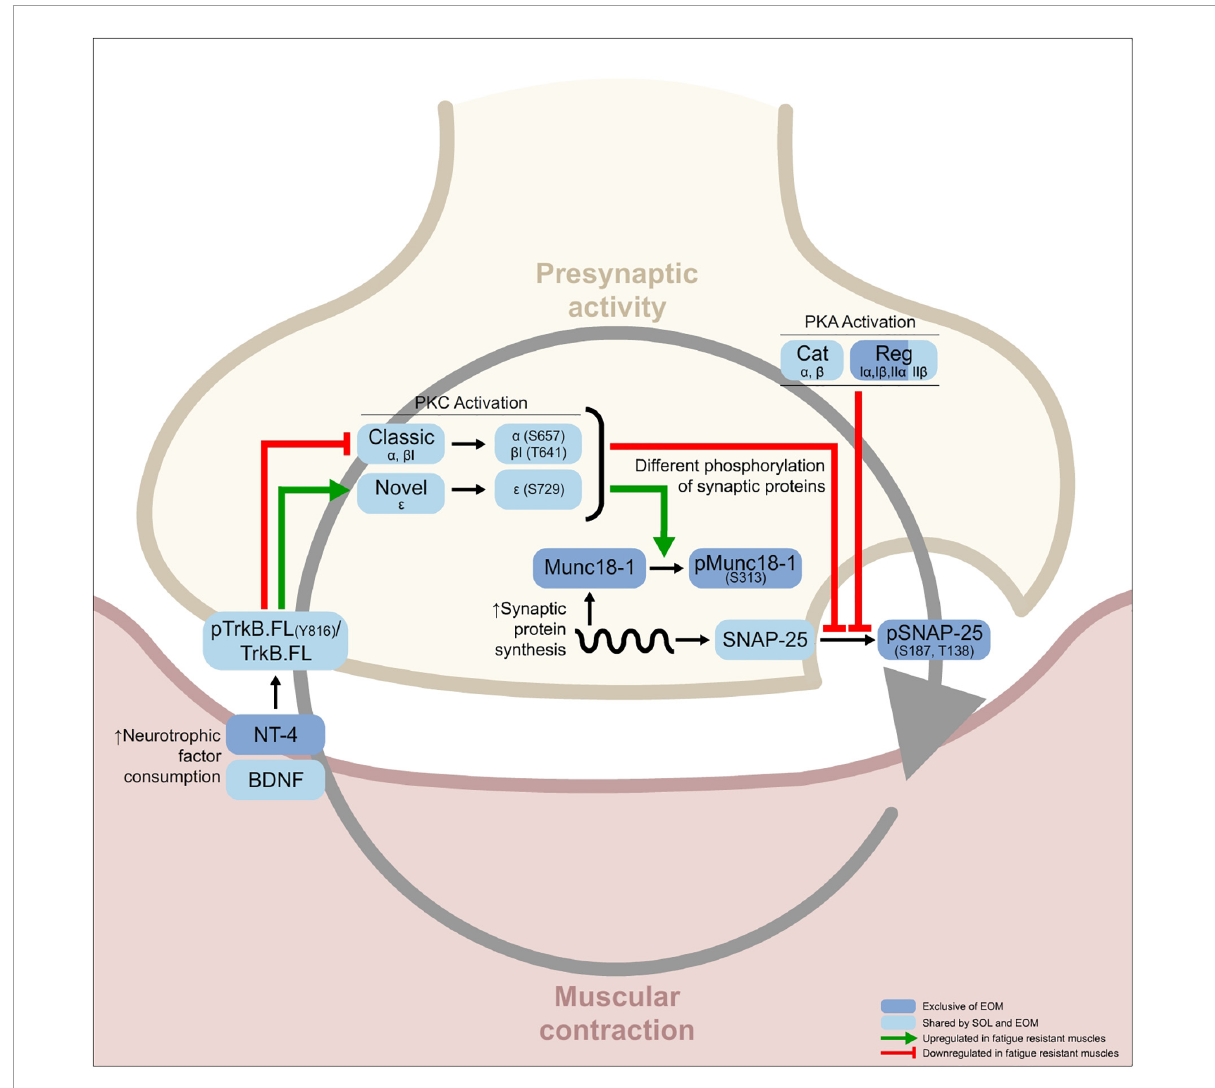
FIGURE1 Graphical abstract showing the differential molecular features of fatigue resistant muscles [soleus (SOL) and extraocular muscles (EOM)] in comparison with fatigable muscles [extensor digitorum longus (EDL) and tibialis anterior (TA)]. Following the circular relation between the presynaptic and postsynaptic components of the neuromuscular junction (NMJ) gray arrow characterized by previous work done in Sprague Dawley rat diaphragms stimulated through the phrenic nerve ex vivo and activating or inhibiting each one of the proteins in the pathway (Obis et al., 2015a,b; Hurtado et al., 2017a,b; Simó et al., 2018, 2019; Cilleros-Mañé et al., 2020, 2021), one can identify that muscular resistance to fatigue is mediated by constant neurotrophic consumption that modulates tropomyosin receptor kinase B (TrkB) phosphorylation ratio. Consequently, PKC activity in both SOL and EOM muscles is modified, which results in a differential balance of synaptic protein phosphorylation between fatigable and fatigue resistant muscles. Also, PKA activity and synaptic protein abundance are differential between fatigue resistant and fatigable muscles. Many protein levels are shared between SOL and EOM, indicated in pale blue squares. However, there are specific differences between the two fatigue resistant muscles SOL and EOM indicated in dark blue